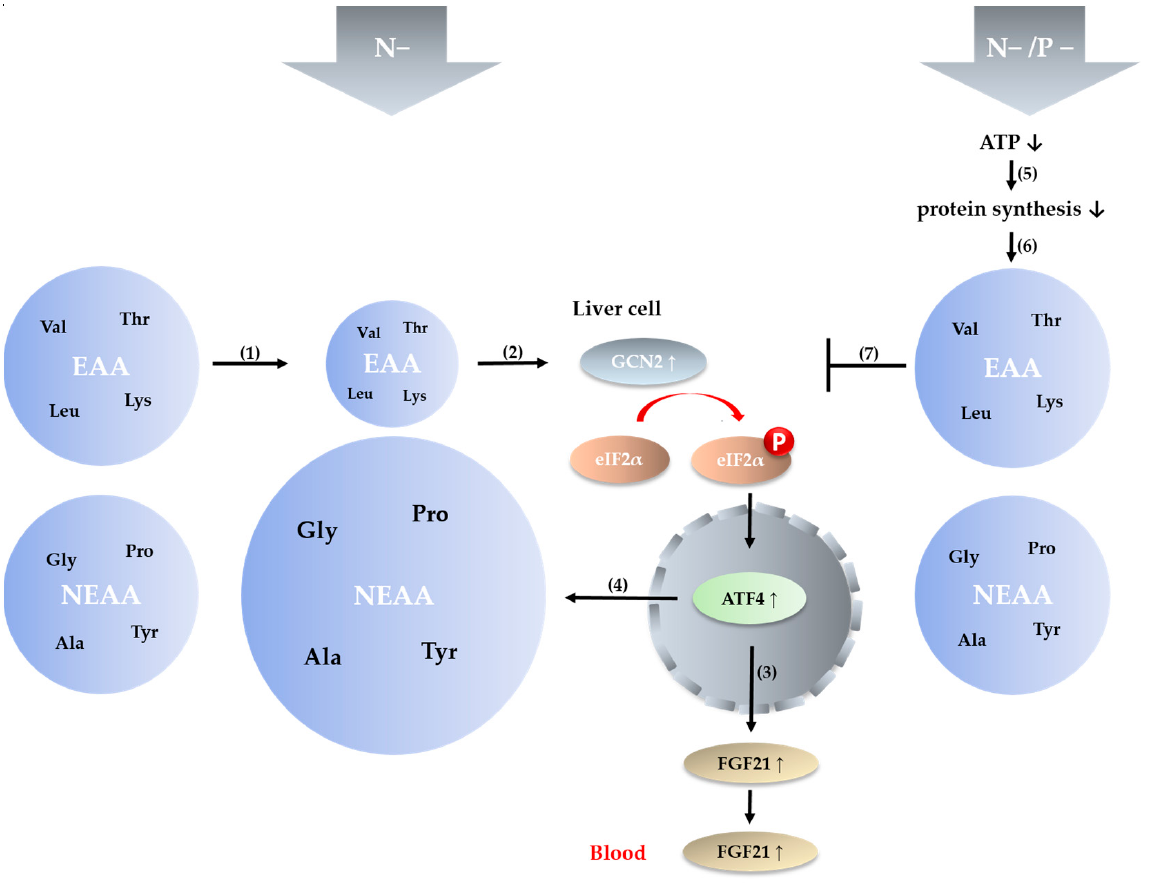
Figure 8. Dietary N reduction leads to depletion of EAA (1), which results in activation of the GCN2/eIF2 α /ATF4 pathway (2) and the induction of FGF21 (3). Increased expression of ATF4- related genes leads to an increase in NEAA (4). Dietary P reduction leads to reduced protein synthesis via reduced availability of ATP (5). EAA are not reduced with simultaneous N reduction (6) and prevent the signaling pathway from being initiated (7).